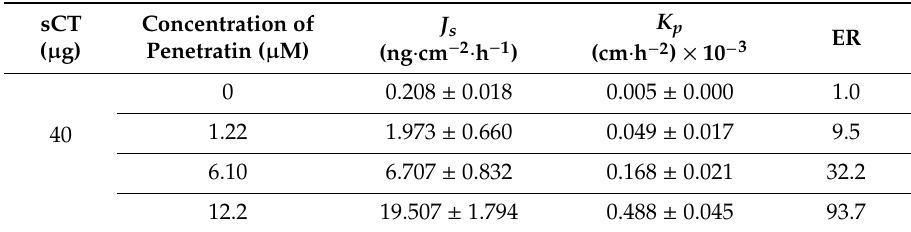
Table 3. Permeation parameters calculated from the sCT transbuccal permeation study. sCT ( µ g)